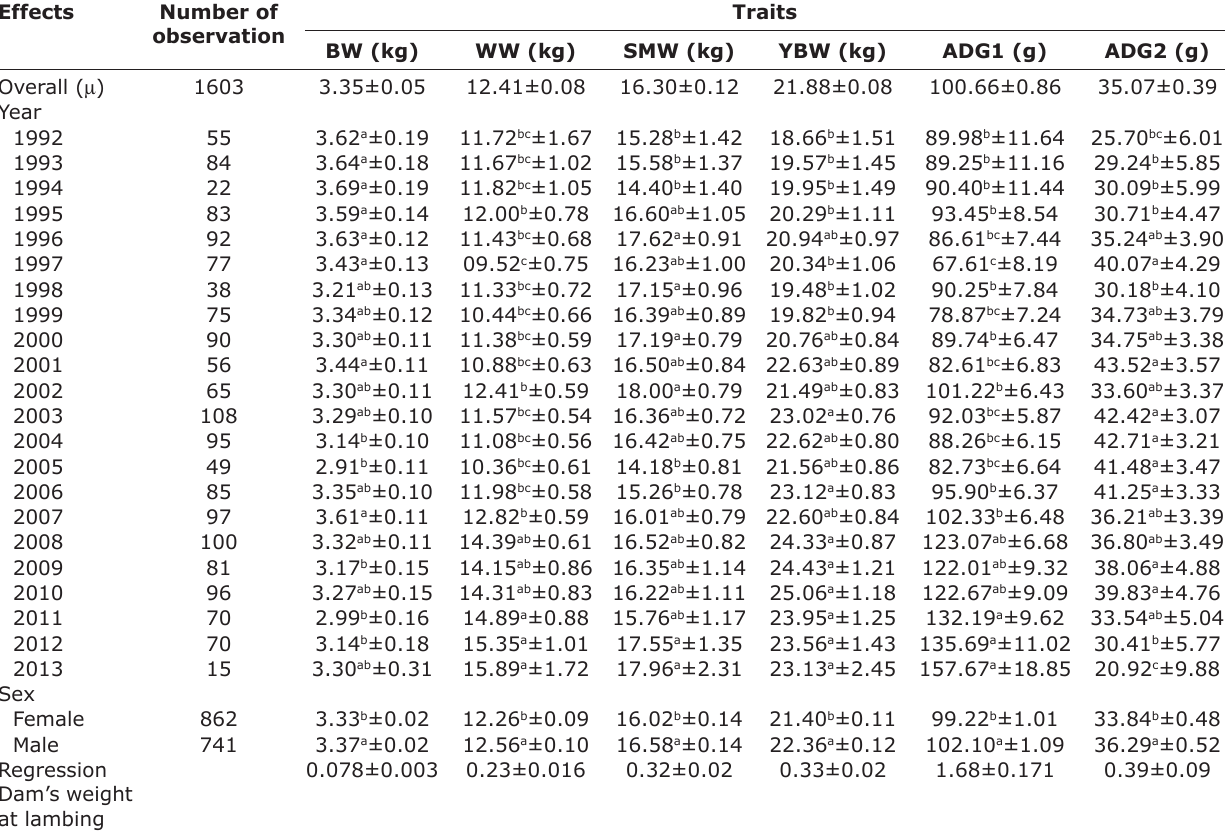
Table-2: Least squares means along with standard errors for growth